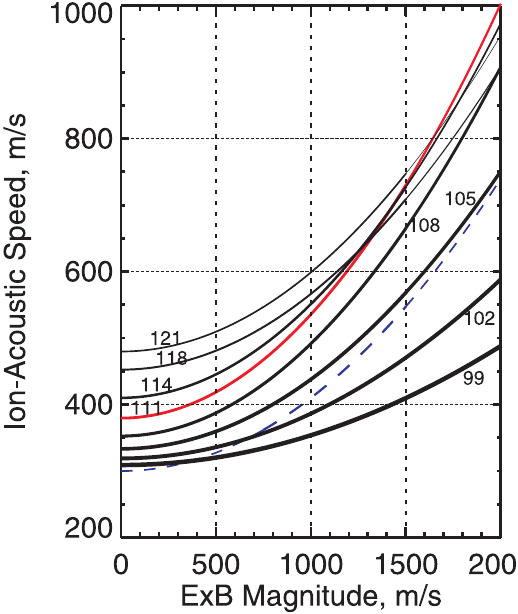
Fig. 1. Variation of the isothermal ion-acoustic speed with E × B magnitude at various heights in the ionosphere (99–121km) as inferred from EISCAT measurements between ∼ 12:00 and 18:00MLT. Dashed line is the dependence of the VHF radar ve- locity upon the E × B magnitude reported by Nielsen and Schlegel (1985). Red curve at 111km corresponds to the height with strongest variation.